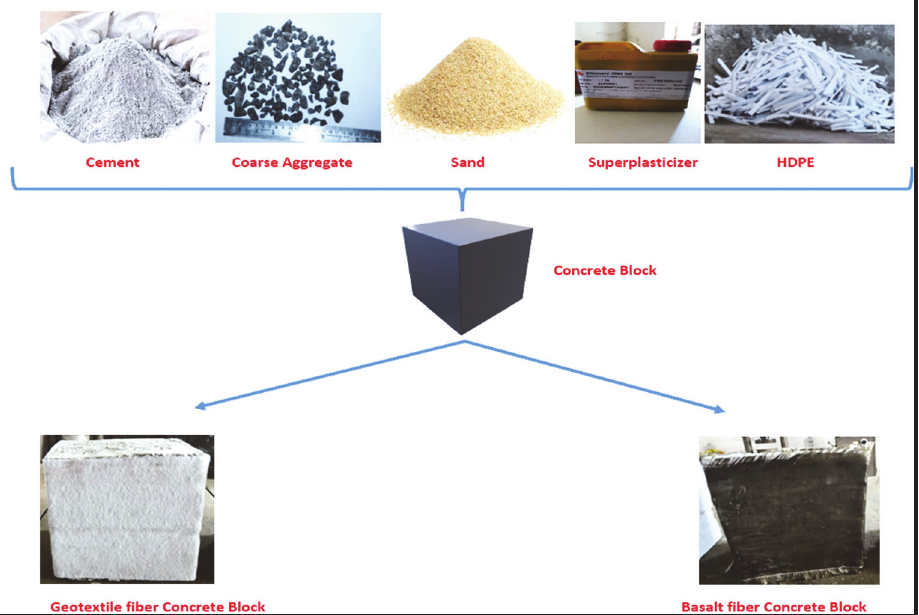
Figure 1: Process of sample preparation.